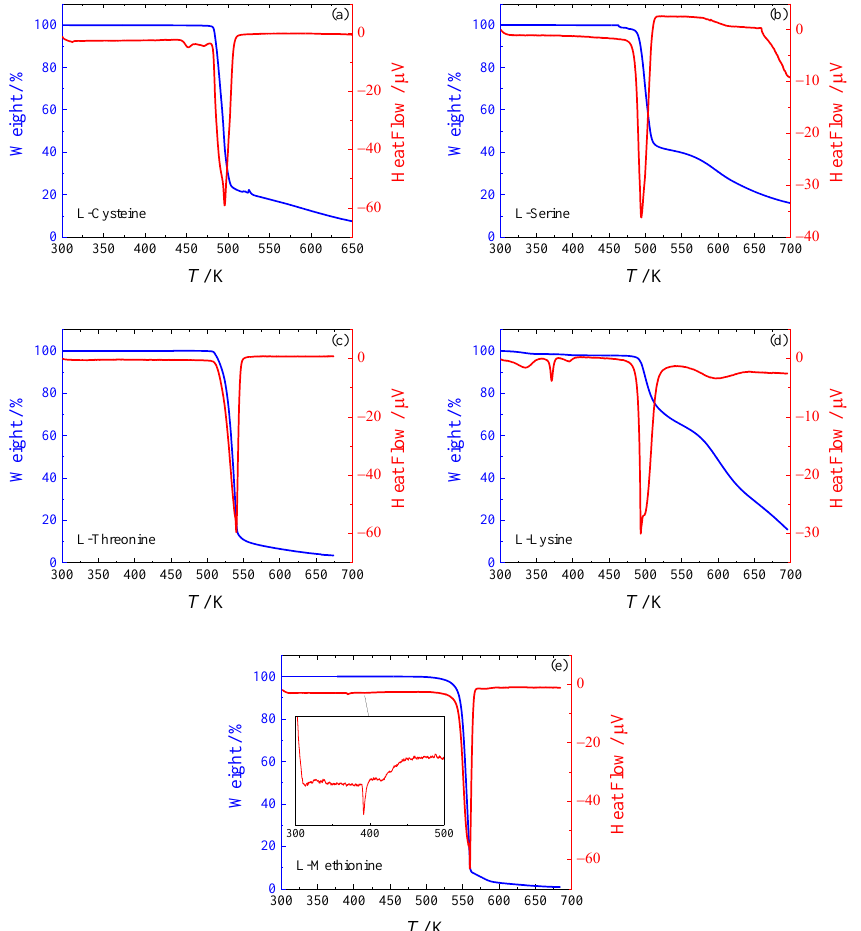
Figure 1. TGA analysis of studied amino acids. ( a ) L-cysteine, ( b ) L-serine, ( c ) L-threonine, ( d ) L-lysine, ( e ) L-methionine (with an inset detailing the heat flow at temperatures before decomposi- tion).